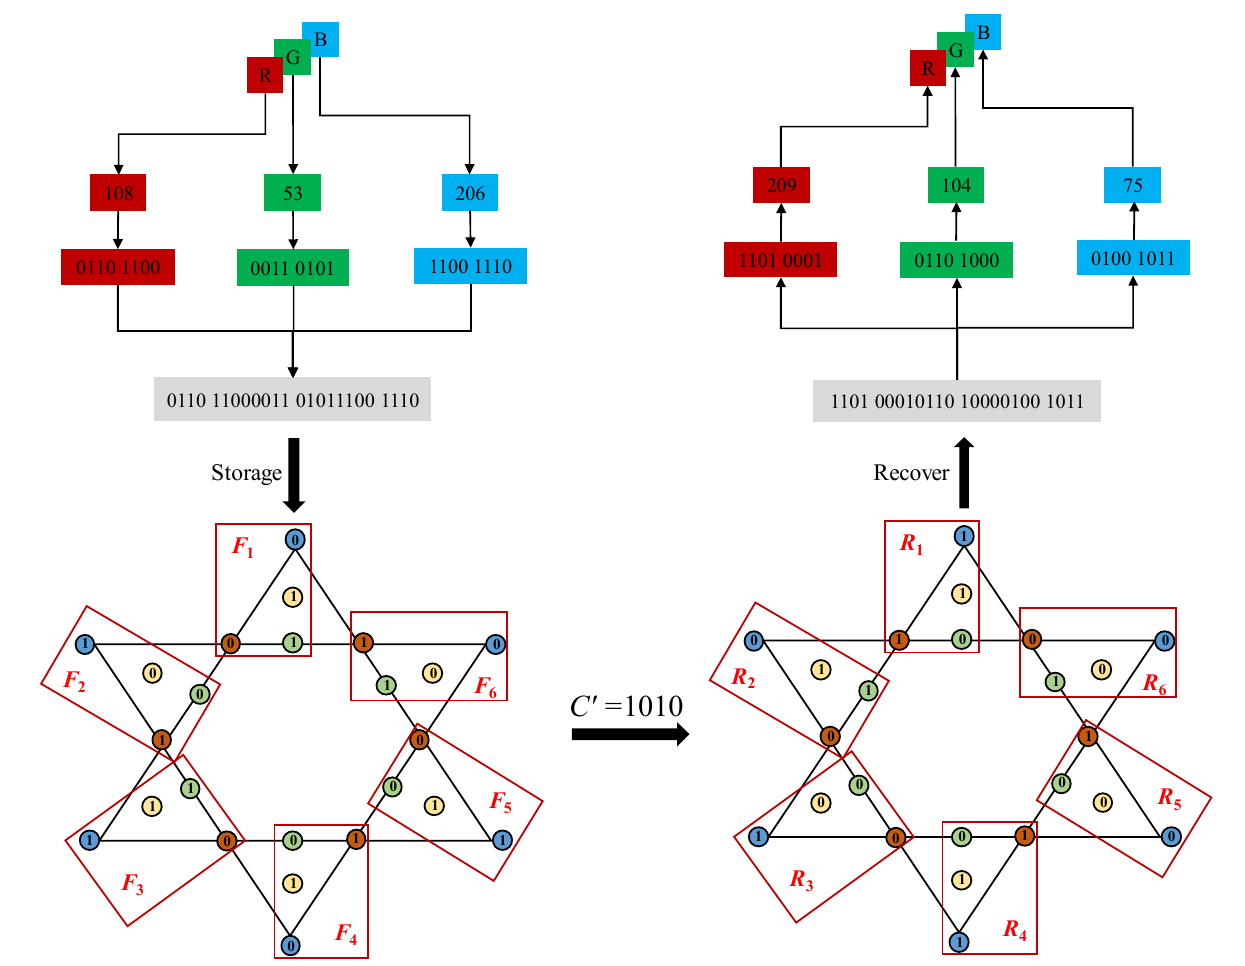
11 of 33 Algorithm 2: Six-sided star diffusion Input: Pixel A of 24 bits, squence D Output: Transformed pixel C 1: